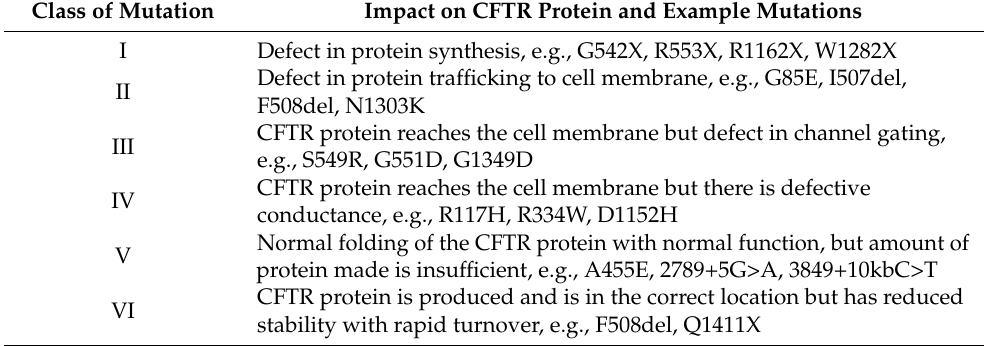
Table 1. Cystic fibrosis transmembrane conductance regulator ( CFTR ) class mutations and consequent impact on CFTR